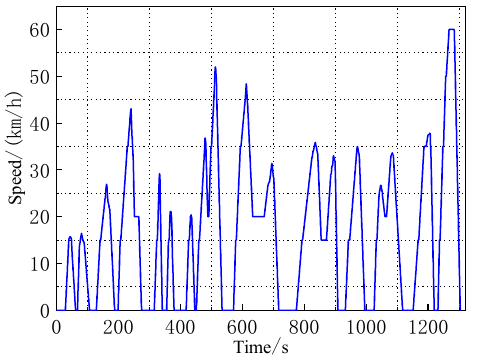
Figure 11. The information of China city road cycle.